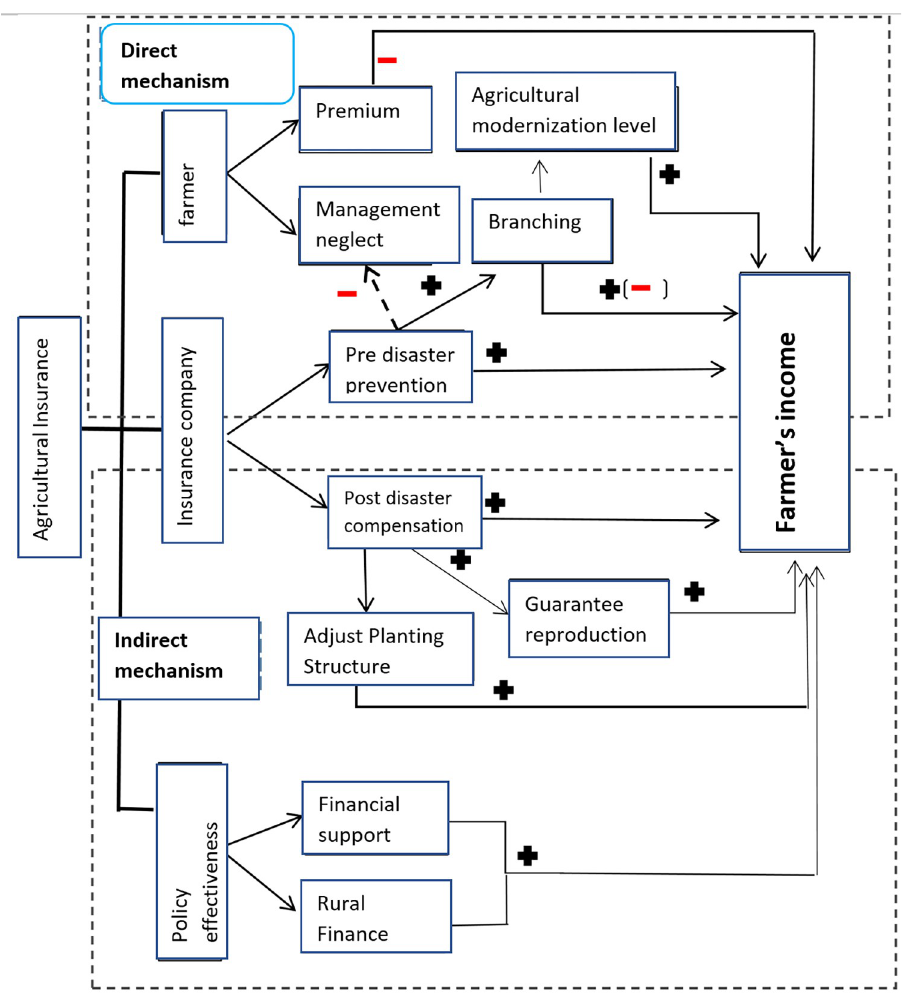
Fig 1. A road map of the impact of agricultural insurance on farmers’ income. Source: authors’ elaboration.